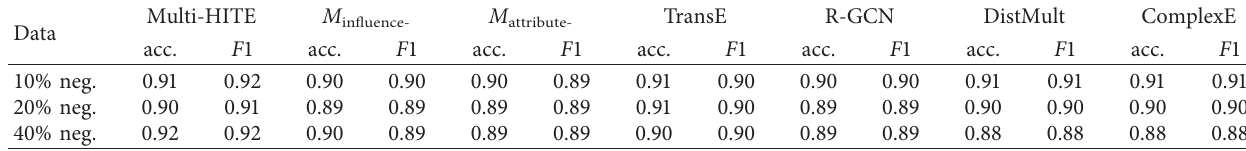
Table 4: Performance of all the methods over data with different levels of noise.